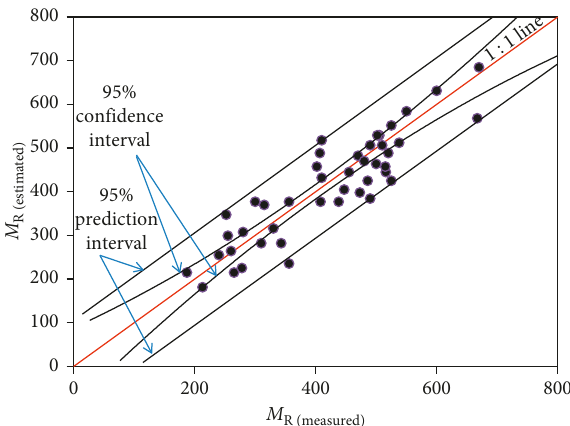
Figure 6: A comparison of estimated and measured M R values along the unity Table 6: Summary of the statistical analysis of the proposed model at an alpha value of 0.05 which matches to 95% confidence level. Case